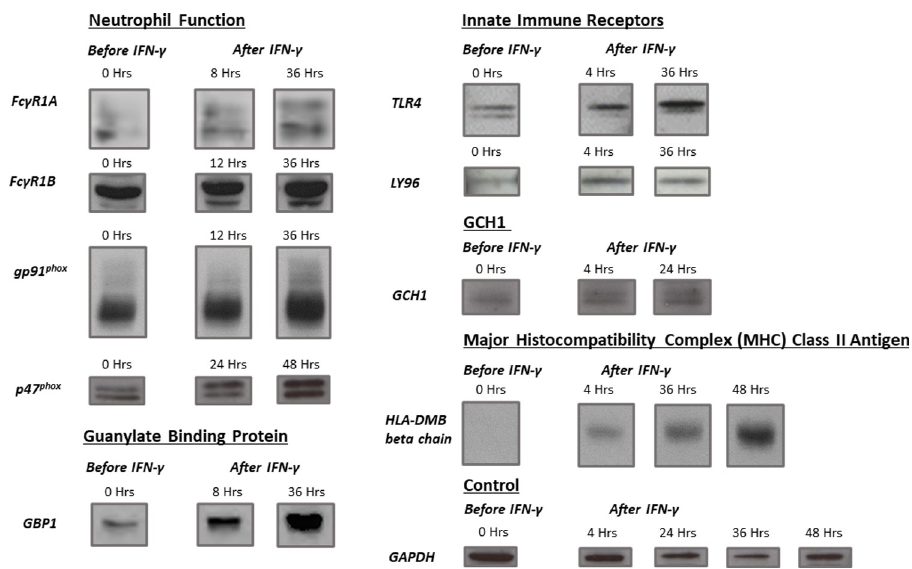
Fig 8. Western blot analysis for selected proteins. The levels of selected proteins for genes in Table 1 were investigated by Western blot. Lanes containing neutrophil lysate (50 μ g protein) prior to administration of IFN- γ (time 0) on the left and samples from various times after administration are on the right. These are representative results from at least three separate subjects for each protein. The housekeeping enzyme glyceraldehyde 3-phosphate dehydrogenase (GAPDH) was included as a loading